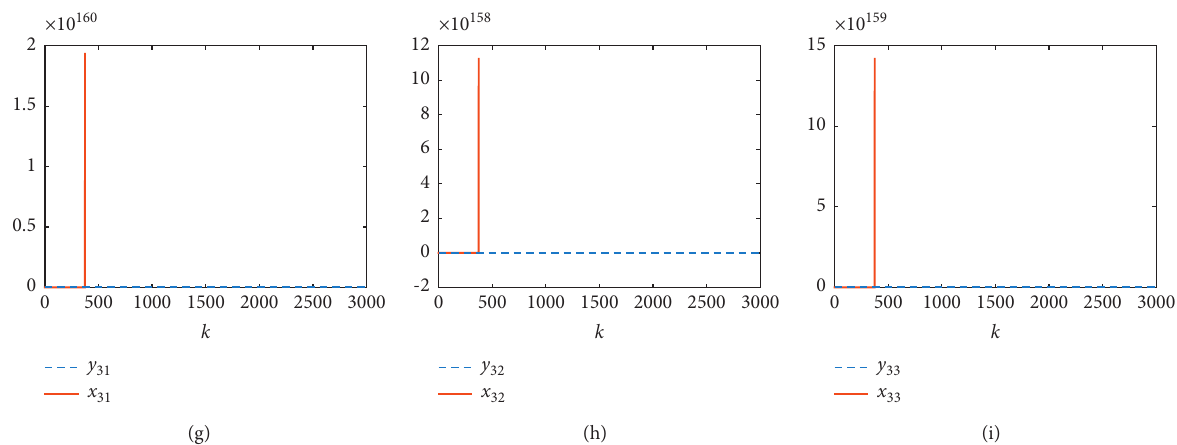
Figure 12: Solution trajectories synthesized by Y A − 1 � 0 . 001 s and c � 1 . 0). k + 1 (i.e., k + 1 ) and by DDD10i algorithm (55) for example 2 (with ϵ and x . (b) Trajectories of y and x . (c) Trajectories of y and x . (d) Trajectories of y and x . (e) Trajectories of (a) Trajectories of y 11 11 12 12 13 13 21 21 y and x . (f) Trajectories of y and x . (g) Trajectories of y and x . (h) Trajectories of y and x . (i) Trajectories of y and x . 22 22 23 23 31 31 32 32 33 33